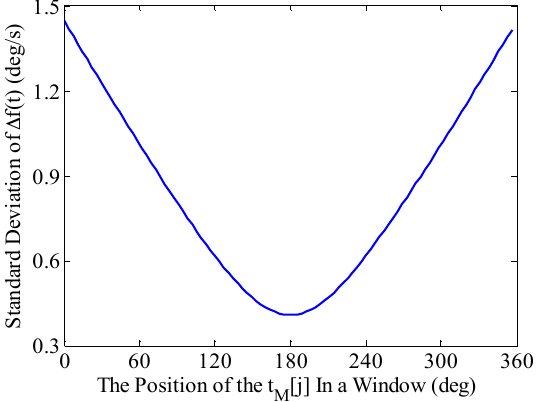
Figure 7. Impact of t M [ j ]’s position within the measurement window on the accuracy of the BCZT.